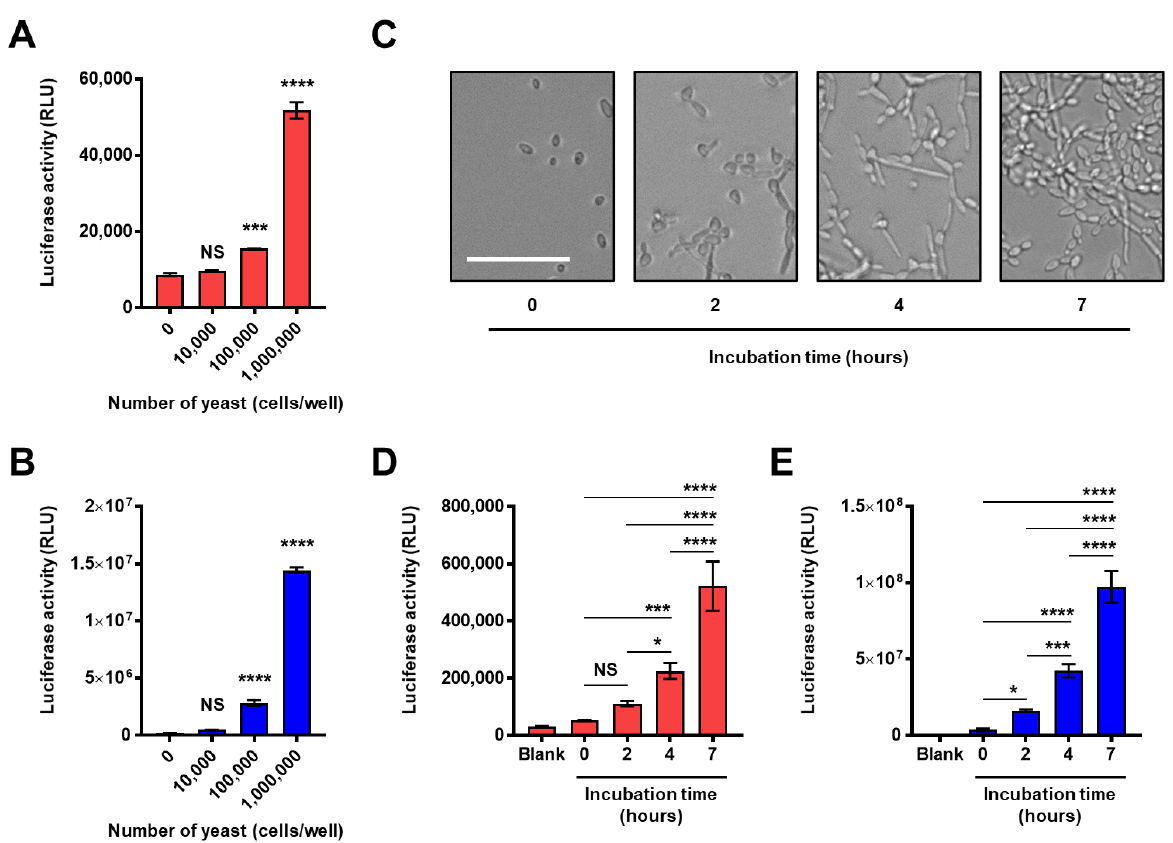
Figure 5. Reconstitution of NanoLuc on the cell surface of live C. albicans . ( A , B ) Reactivity to yeast form C. albicans . Yeasts in 96-well white V-bottom plate (0, 10 4 , 10 5 or 10 6 cells/well) were washed, treated with the mixture solution of ( A ) supBGRP-LgBiT and supBGRP-SmBiT or (B) supBGRP-LgBiT and Neg1-E321Q-SmBiT, and the NanoLuc activity measured. ( C ) Images showing the proliferation of C. albicans (10 5 cells/well) in a 96-well clear flat bottom plate. ( D , E ) Reactivity to hypha form C. albicans . Yeasts in 96-well white V-bottom plate (10 5 cells/well) were cultured for different time periods (0, 2, 4 or 7 h) at 37 ◦ C. The hyphae were washed and analyzed with ( D ) supBGRP-LgBiT and supBGRP-SmBiT or ( E ) supBGRP-LgBiT and Neg1-E321Q-SmBiT. Data are presented as the mean ± SD ( n = 3 for A, B, n = 4 for D, E) and are representative results from at least two independent experiments. Significant differences from blank (Tukey’s test for A, B) or between different incubation time (Dunnett’s test for D, E): * p < 0.05, *** p < 0.001, **** p < 0.0001, NS: not significant. Scale bar: 50 µ